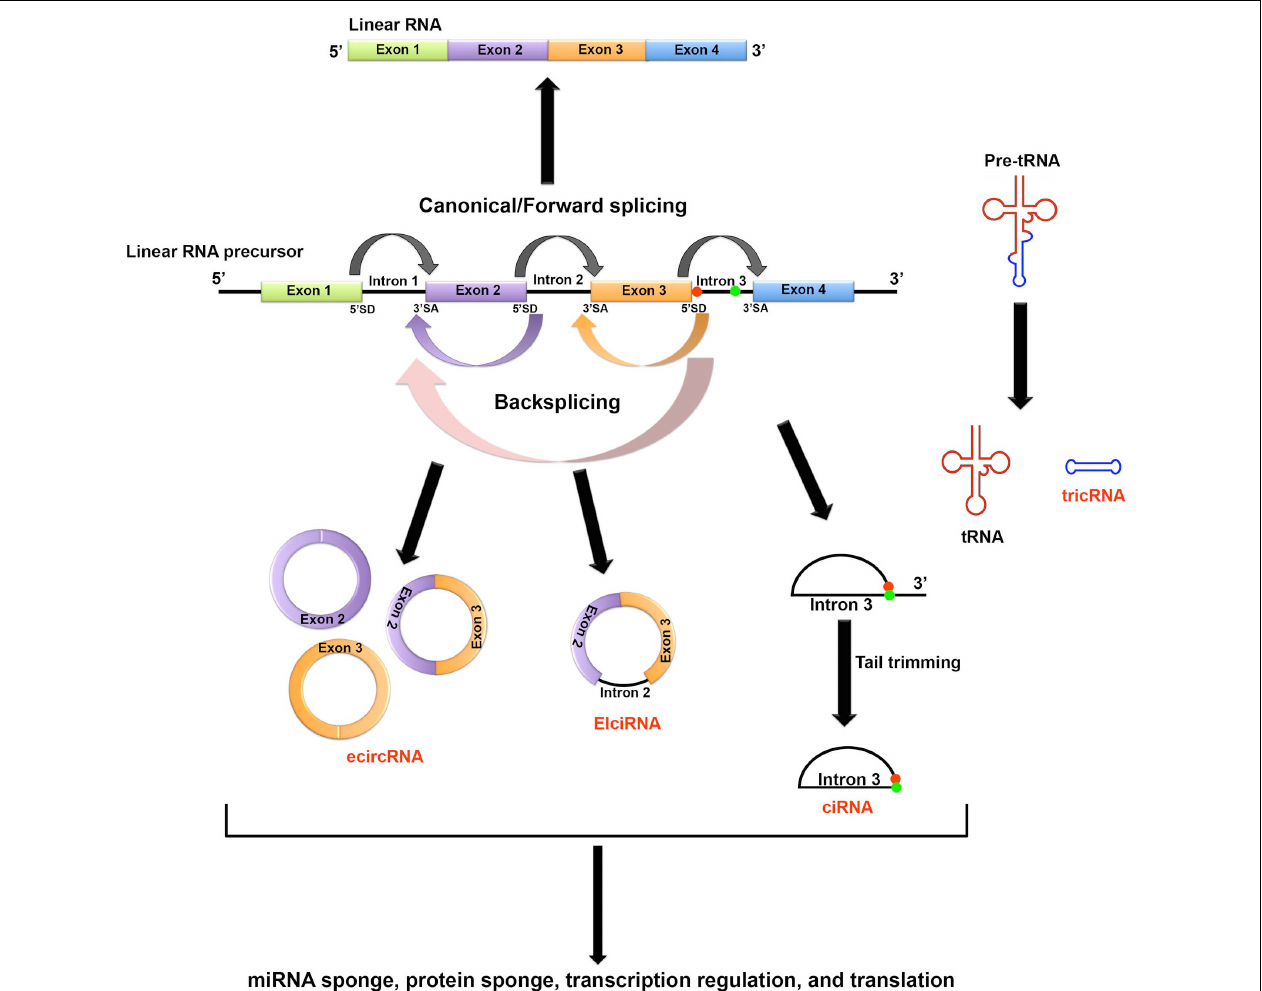
FIGURE 1 | Biogenesis and potential functions of circRNAs. Based on the parental gene component that’s carried by the circRNAs, circRNAs can be classified to four major types. (1) The most common type is the exonic circRNAs (ecircRNAs) which contain only one or multiple exons; (2) The exon-intron circRNAs (EIciRNAs) carry both exons and introns; (3) The circular intronic RNAs (ciRNAs) carry introns only; and (4) The tRNA intronic circRNAs (tricRNAs) are formed by circularization of the excised tRNA introns. The formation of ecircRNAs and EIciRNAs requires a special type of splicing known as backsplicing, which allows a downstream 5 (cid:48) splice donor (SD) to react with an upstream 3 (cid:48) splice acceptor (SA). Thus, a 3 (cid:48) –5 (cid:48) phosphodiester bond can be established to circularize the RNA molecule. ciRNAs are generated by lariat introns removed from pre-mRNAs by canonical splicing. A consensus 7-nucleotide GU-rich sequence near the 5 (cid:48) splice donor (shown as red dot in the figure) and an 11-nucleotide C-rich sequence near the branchpoint site (shown as green dot in the figure) can help prevent the lariat from debranching and exonuclease attacking. Stable ciRNAs can then be formed after trimming the 3 (cid:48) tail downstream from the branchpoint. Lastly, tricRNAs are formed by directly linking the free ends of introns excised from the pre-tRNAs. circRNAs can function as molecular sponges to sequester miRNA and protein. In general, circRNAs mainly function as non-coding regulatory transcripts. However, some circRNAs can be translated through either IRES-mediated or m 6 A-mediated non-canonical cap-independent translation